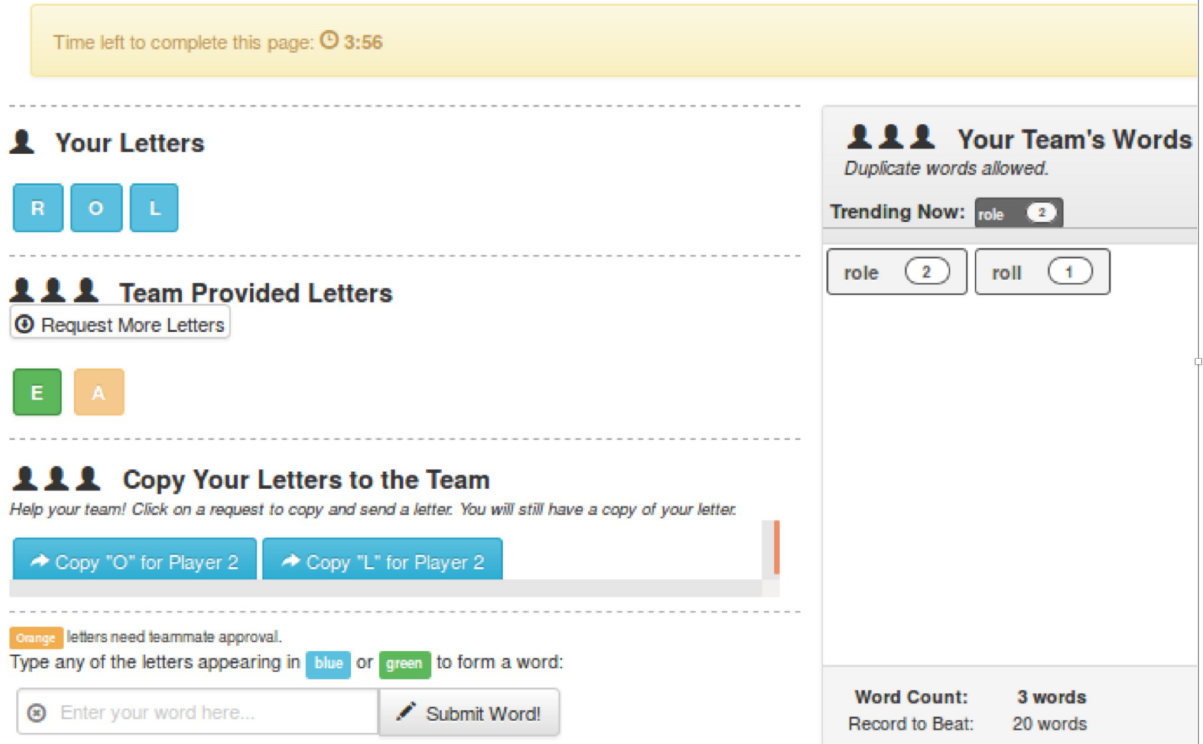
Fig 12. The anagram game screen, phase-2, for one player. This player has own letters “R,” “O,” and “L” and has requested an “E” and “A” from neighbors. The “E” is green, so this player’s request has been fulfilled and so “E” can be used in forming words; but the request for “A” is still outstanding so cannot be used in words. Below these letters, it shows that Player 2 has requested “O” and “L” from this player. This player can reply to these requests, if she so chooses. Below that is a box where the player types and submits new words.